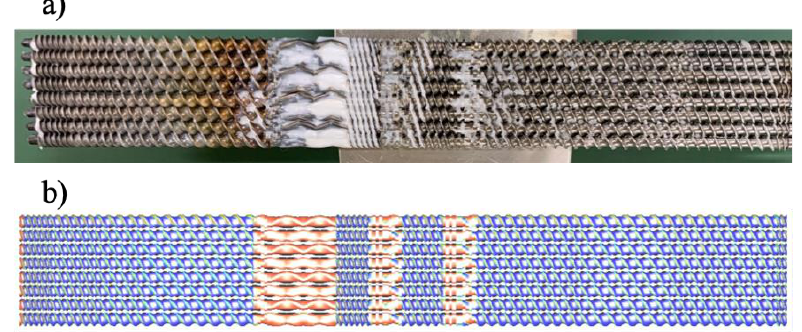
Figure 4. ( a ) Photograph of the fill of polymer resins on the retrieved screws of an octa-screw extruder (from right to left: hopper side to exit side), and ( b ) the simulated degree of fill.